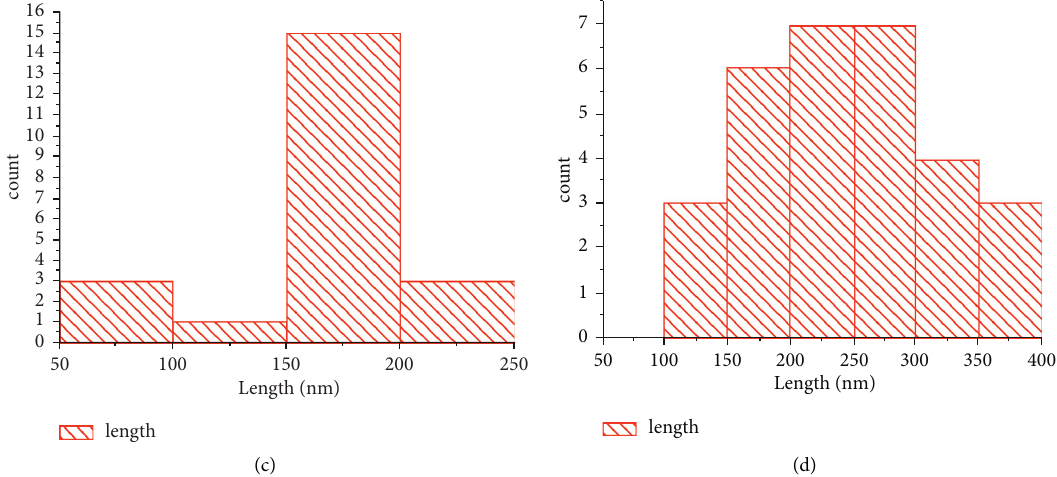
Figure 7: TEM micrographs of CaTiO obtained after calcination at (c) 900 ° C and (d) 1000 ° C.